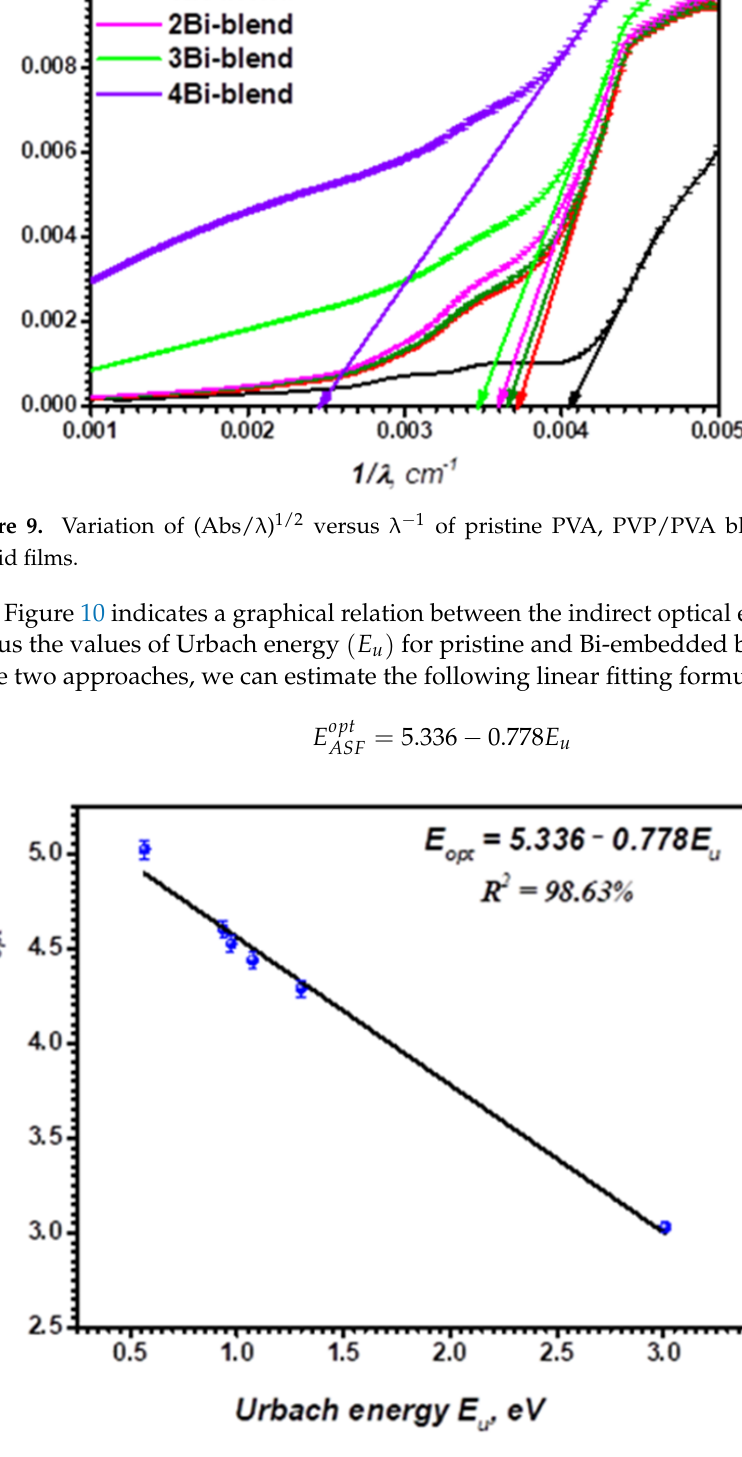
Figure 10. Variation of the average indirect optical band gap, 𝐸 (cid:3042)(cid:3043)(cid:3047)(cid:3028)(cid:3049) , vs Urbach energy, 𝐸 (cid:3048) , of pristine PVP/PVA blend, and Bi-blend hybrid films 3.4.3. Extinction Coefficient and Refractive Index Investigations The coefficient of extinction index ( k ) is the quantity of energy absorbed when the electromagnetic radiation propagated through the material. It indicates the proportion of light losses owing to the penetrating material’s absorption and dispersion per unit dis- tance. In addition, it depends on the structural defects and the amount of the material’s charged particles. The study of this parameter is essential for future optoelectronic appli- cations of the materials under investigation. It is the imaginary component of the complex index of refraction, 𝑛 = 𝑛 (cid:3398) 𝑖𝑘 , and evaluated in terms of α by using the relationship [55]: 𝑘 = 𝛼𝜆 4𝜋